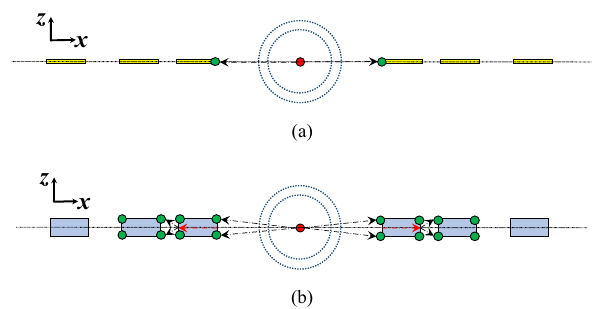
Figure 4. Fresnel zones and Spherical Source Excitation (F → 0), ( a ) Reflector/Absorber Case, and ( b ) Dielectric